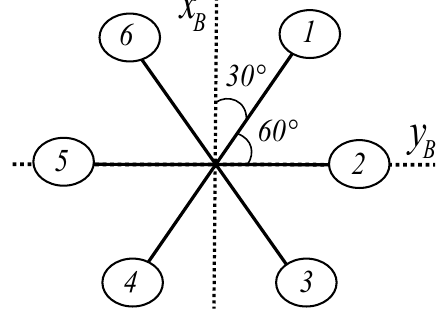
Figure 2. Geometry of